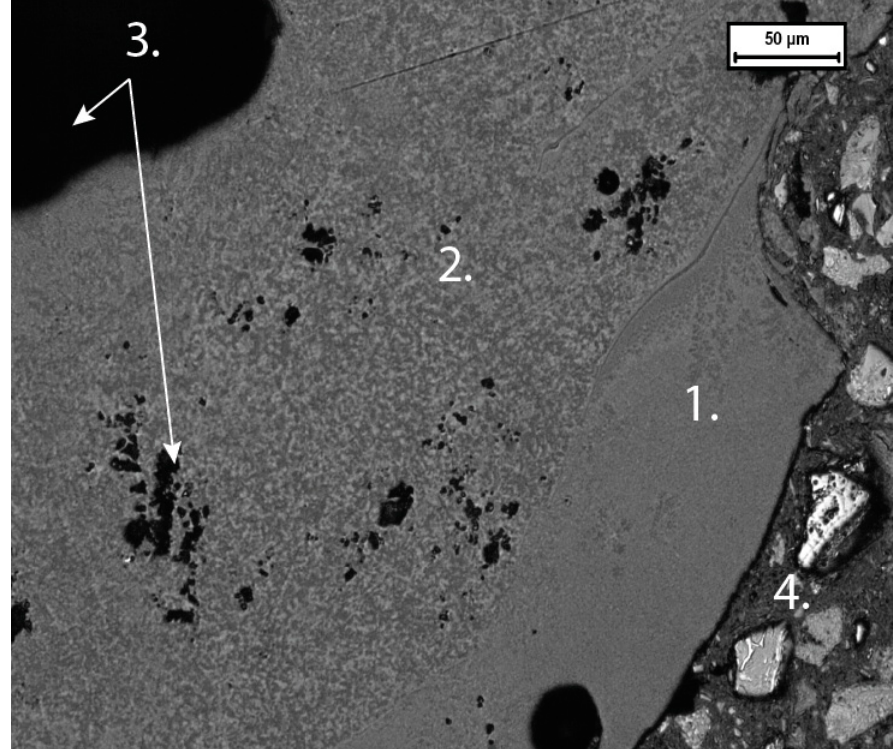
Figure 6. Light optic microscope (LOM) picture of 2D cross-section surface of slag sample. The numbers represent different zones in the sample.